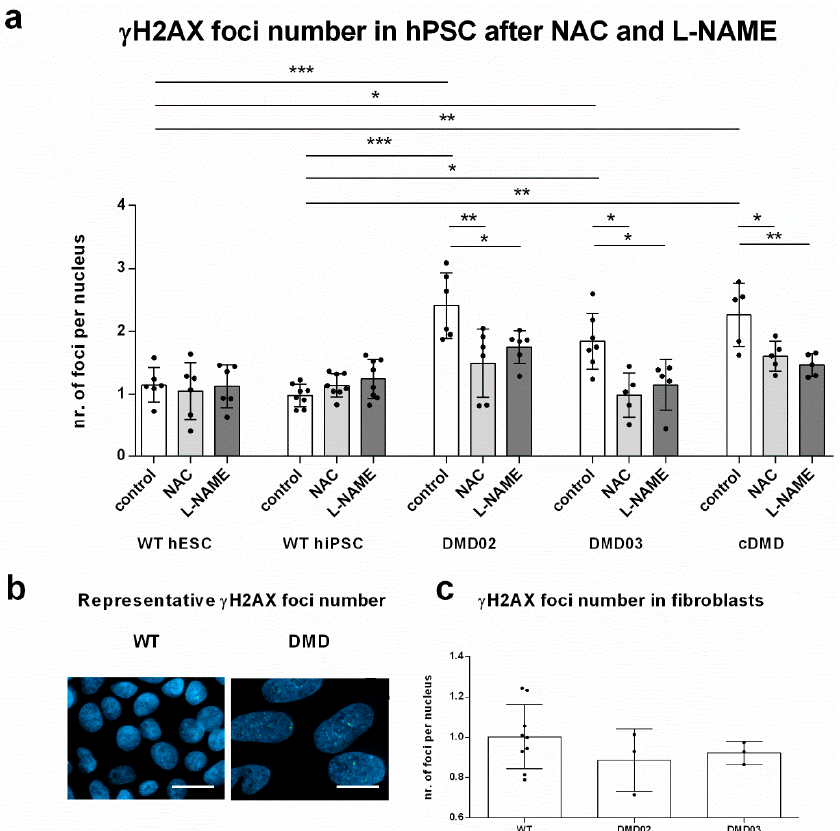
Figure 5. Elevated ROS level in DMD hPSC leads to DNA damage. ( a ) Numbers of γ H2AX foci representing the spontaneous DNA damage in DMD02, DMD03 and cDMD hPSC lines were significantly elevated compared to WT hESC and WT hiPSC. Spontaneous formation of γ H2AX foci in all DMD hPSC lines significantly decreased after the NAC treatment to the level of WT hPSC. No effect of NAC on the WT hPSC lines was observed. All DMD lines show significant decrease in γ H2AX foci formation after treatment with L -NAME corresponding to the decrease detected after NAC treatment. WT hiPSC show increase after L -NAME treatment. Statistical difference was evaluated by one-way ANOVA and Sidak’s multiple comparison test (* p < 0.05, ** p < 0.01, *** p < 0.001) for γ H2AX foci number in between different lines, and unpaired Student’s t -test comparing the NAC/L/NAME treated cells to corresponding untreated control cells. Error bars represent standard deviation. ( b ) Representative image of γ H2AX foci staining in CCTL14 (WT) and DMD02 (DMD) hiPSC showing higher number of γ H2AX foci number in DMD nuclei compared to WT nuclei. γ H2AX foci are stained in green, nuclei in blue with DAPI. Line represents 20 µ m. ( c ) DNA damage is not increased in DMD fibroblasts before reprogramming. γ H2AX foci number per nucleus in DMD fibroblasts from both DMD patients used for reprogramming does not differ from WT foreskin fibroblasts. Statistical difference was evaluated by one-way ANOVA. The errorbars show standard deviation. At least 3 biological repetitions were used in each experiment, exact value for each is represented by • in each